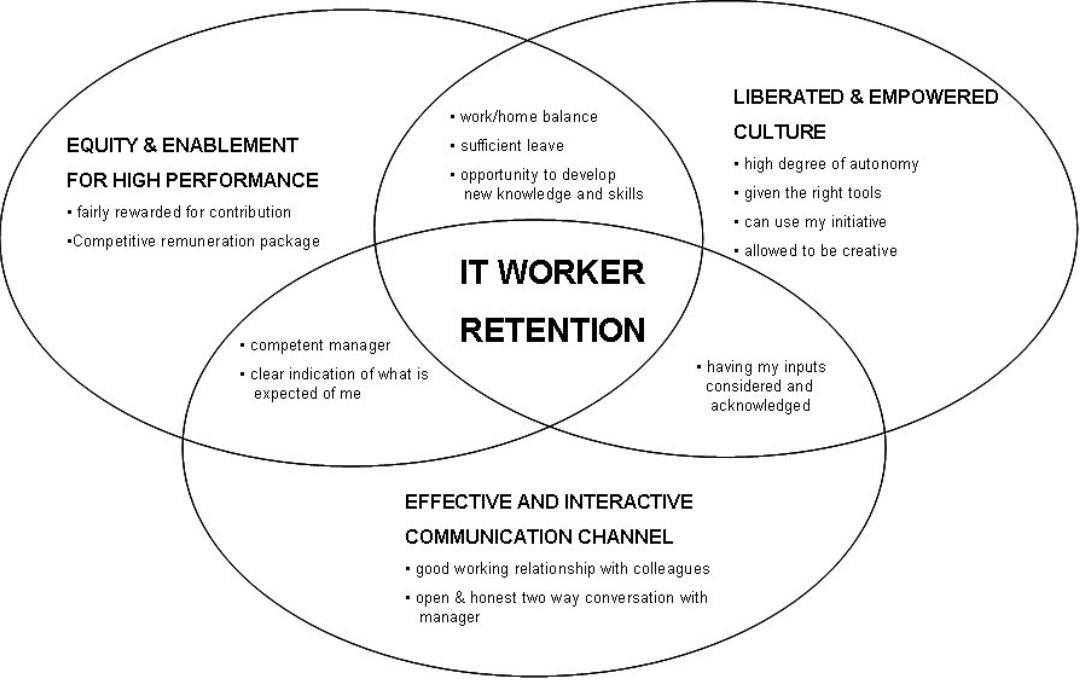
Figure 1: Issues perceived to affect the retention of IT